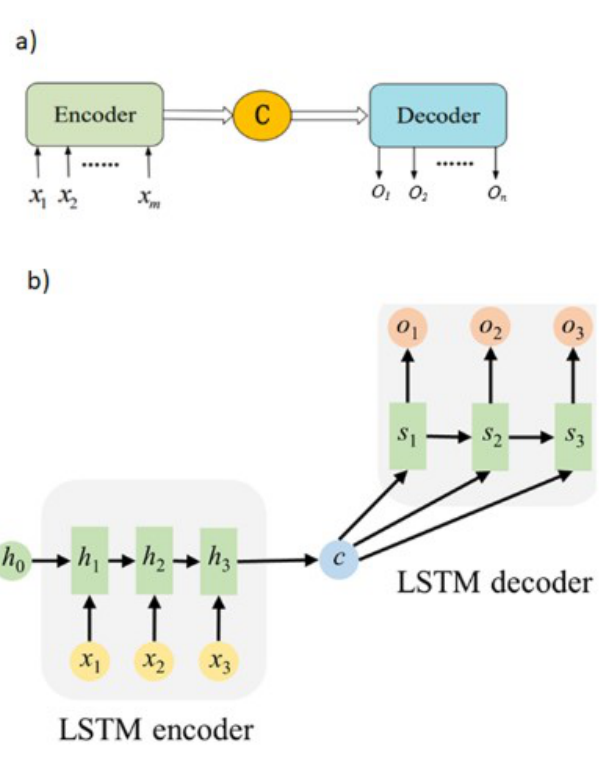
Figure 2. The schematic structure of the proposed sequence-to-sequence model. ( a ) A basic encoder- decoder system; ( b ) An extended encoder-decoder system with LSTM